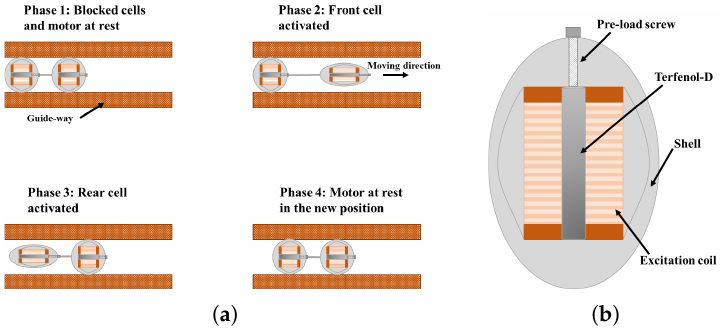
Figure 3. Sketches of the self-moving linear motor developed in [77]: ( a ) schematic explanation of the cell moving principle; and ( b ) sketch of the prototype actuator and core of the motor.